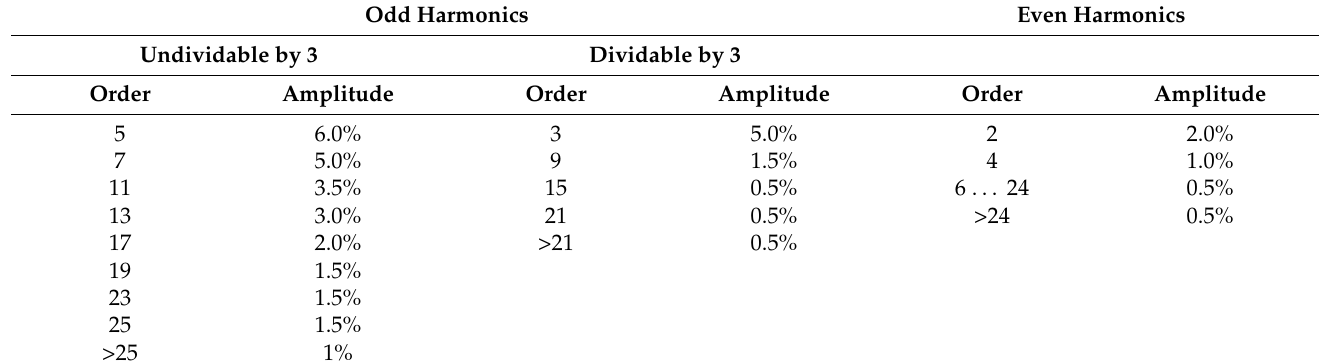
Table 2. The magnitude of particular harmonics of the supply voltage according to the permissible values of EN 50160:2015 [3].